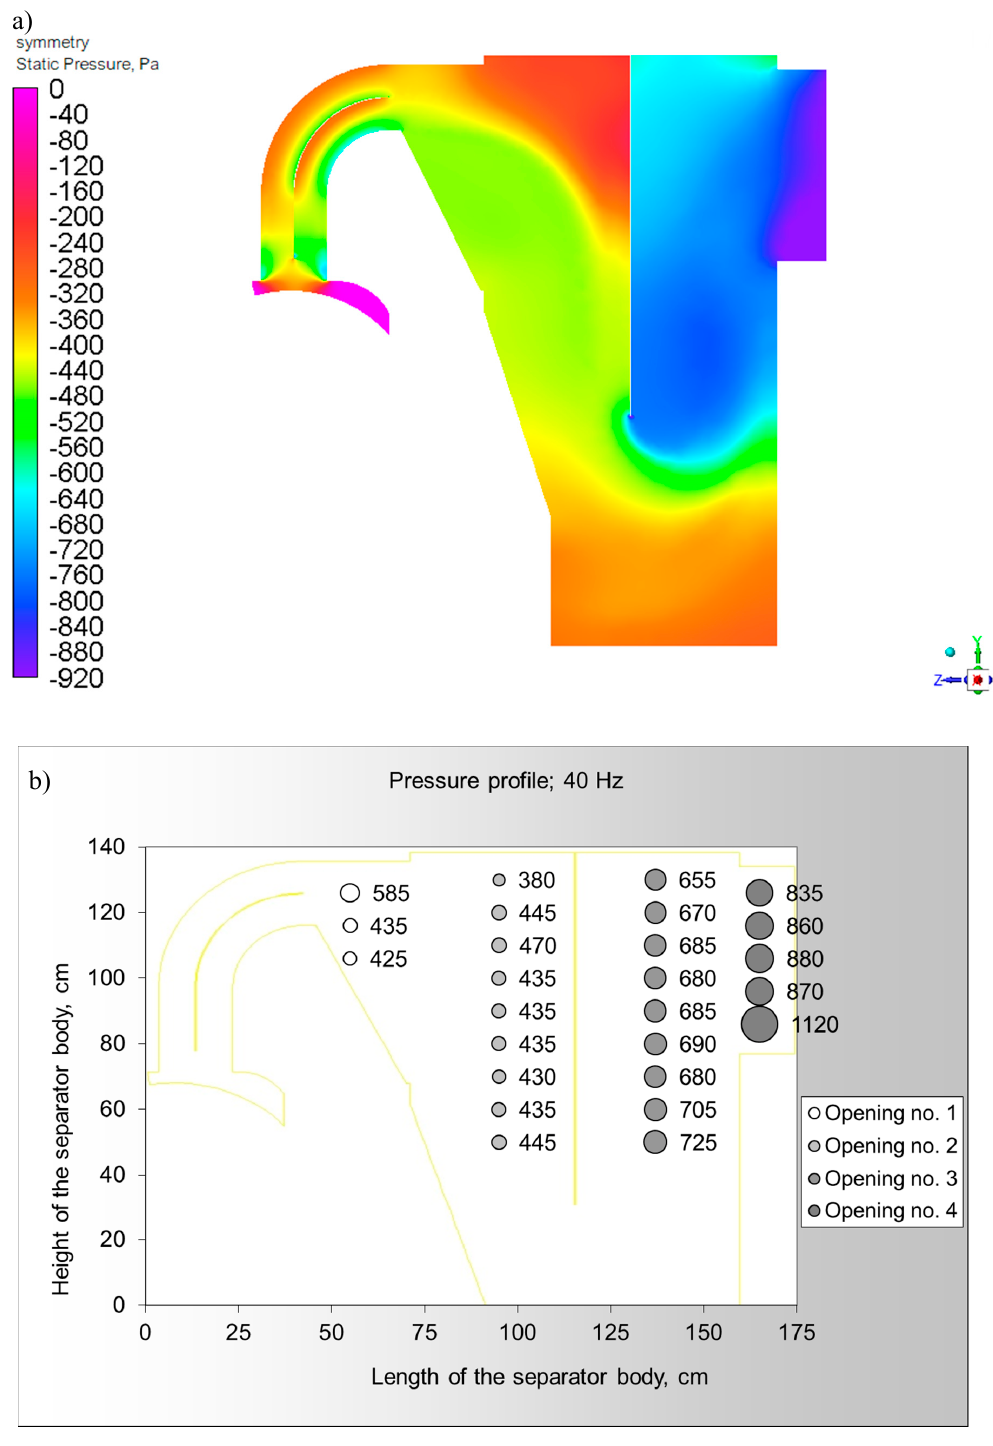
Figure A13. Pressure profile in the sorter symmetry plane (simulation of the main fan at 40 Hz): ( a ) numerical model (gauge pressure) and ( b ) measured (negative pressure).